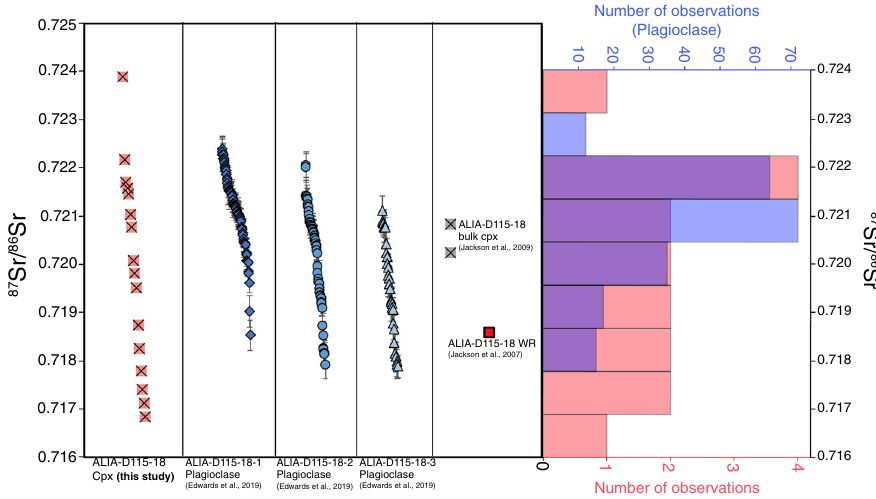
Fig. 2 87 Sr/ 86 Sr values for single clinopyroxene grains measured in this study with LA-ICP-MS spot analyses from three plagioclase grains from the same sample (ALIA-D115-18) 16 . Previous measurements of bulk clinopyroxene 8 (representing 100s of pooled grains; gray squares with an “ x ” ) from this same sample are shown together with the whole rock value 7 (where WR stand for whole rock; red square), clinopyroxenes measured in this study (pink squares with an “ x ” ), and plagioclase analyses from Edwards et al. 16 (blue diamonds, circles, and triangles); all error bars smaller than symbols except where shown and represent 2 σ standard errors. In the histogram, the number of clinopyroxene observations ( n = 17; red bars and red fi gure axis label) span a larger range of 87 Sr/ 86 Sr than the plagioclase 87 Sr/ 86 Sr analyses 16 ( n = 157; blue bars and blue fi gure axis label; error bars are 2 standard errors); where the clinopyroxene and plagioclase histograms overlap, a purple shade is used. The wider range of clinopyroxene 87 Sr/ 86 Sr values compared with the plagioclase from the same sample is consistent with magma mixing modeling using MELTS 24 – 26 and the Magma Chamber Simulator 27 . The magma mixing models show that magma mixing between a ma fi c endmember and a more silicic, trachytic endmember (as derived in this study) precipitates clinopyroxene about 50 °C prior to plagioclase saturation and thus the mixing magmas may be slightly more homogenized at this point, explaining the reduced range of 87 Sr/ 86 Sr exhibited by plagioclase (see Main text and “ Methods ” for more